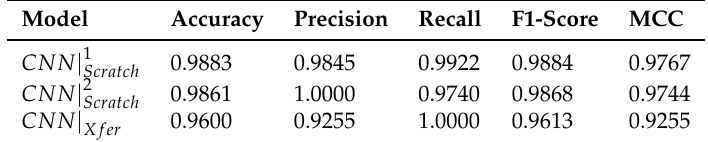
Table 2. Performance summary (on validation dataset) of the best models in our